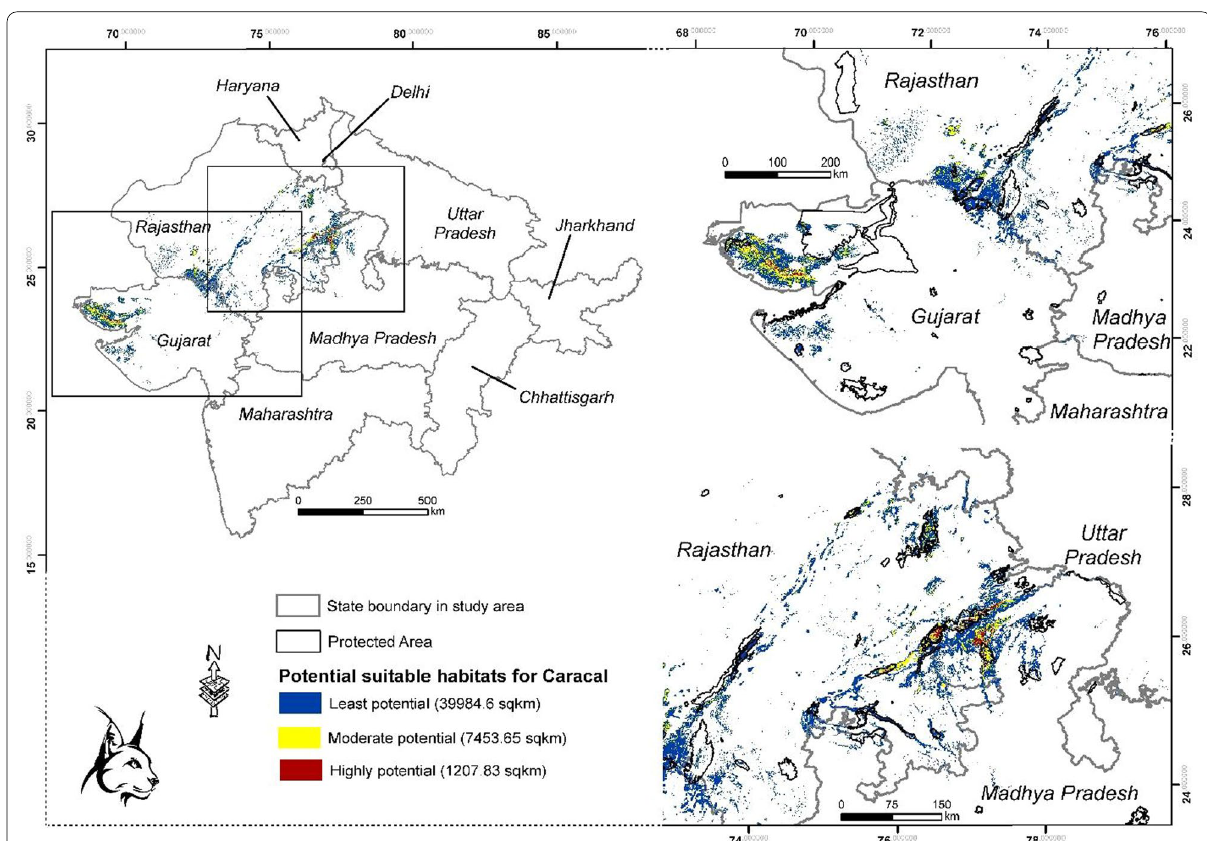
Fig. 3 Map depicting the potentially suitable habitats for caracals after the model correction using nightlight information in the study area. Colors indicate the gradient of habitat suitability for the species, where areas having < 25% suitability are ignored as our ultimate target is to find potentially suitable habitats in dryland states in India